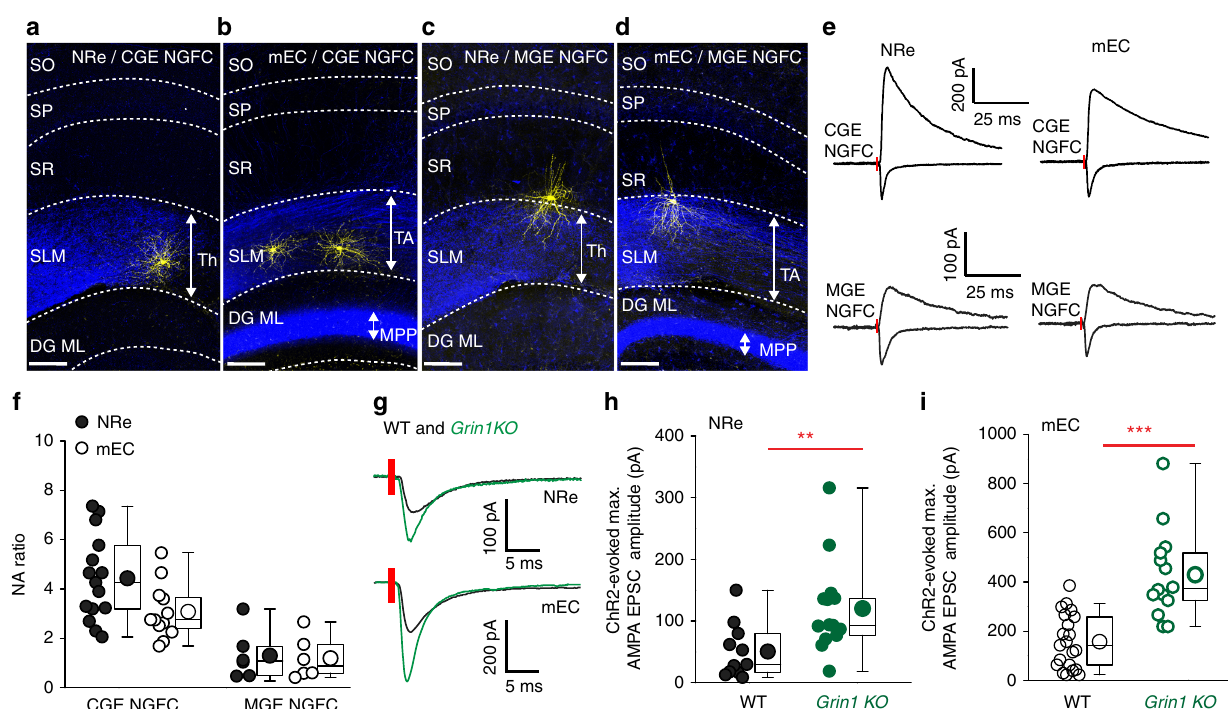
Fig. 6 Optogenetic dissection reveals NMDAR hypofunction results in strengthening of both thalamic and cortical inputs onto NGFCs. a – d Confocal images of biocytin recovered CGE and MGE NGFCs in the hippocampus in WT mice injected with viral channelrhodpsin into the thalamic nucleus reuniens (NRe) or medial entorhinal cortex (mEC; Methods section for details). Note: images are pseduocolored for enhanced contrast. Scale bars , 100 μ m. e Single trace examples of light-evoked AMPAR and NMDAR EPSCs in CGE and MGE NGFCs elicited by NRe and mEC afferent fi bers. f NA peak amplitude ratios in